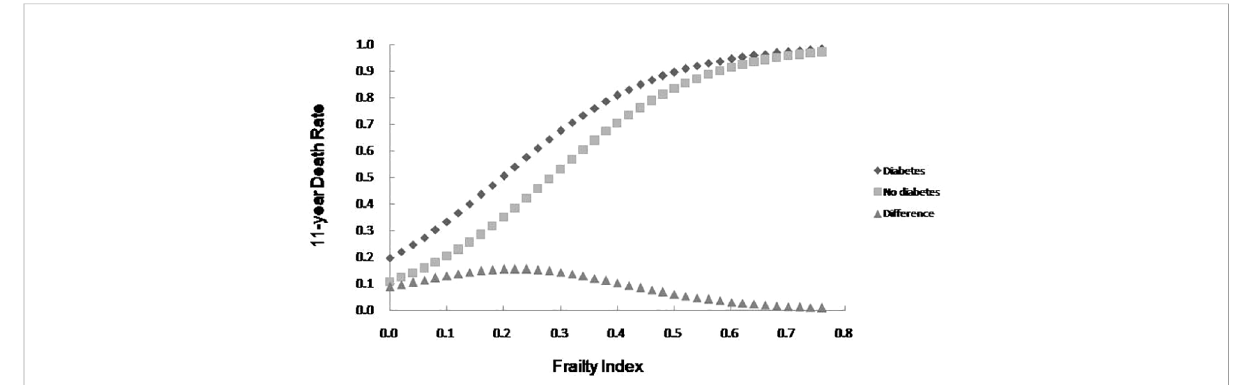
FIGURE 2 The 11-year death rate as a function of the FI and the mortality difference between older adults with diabetes and no diabetes.